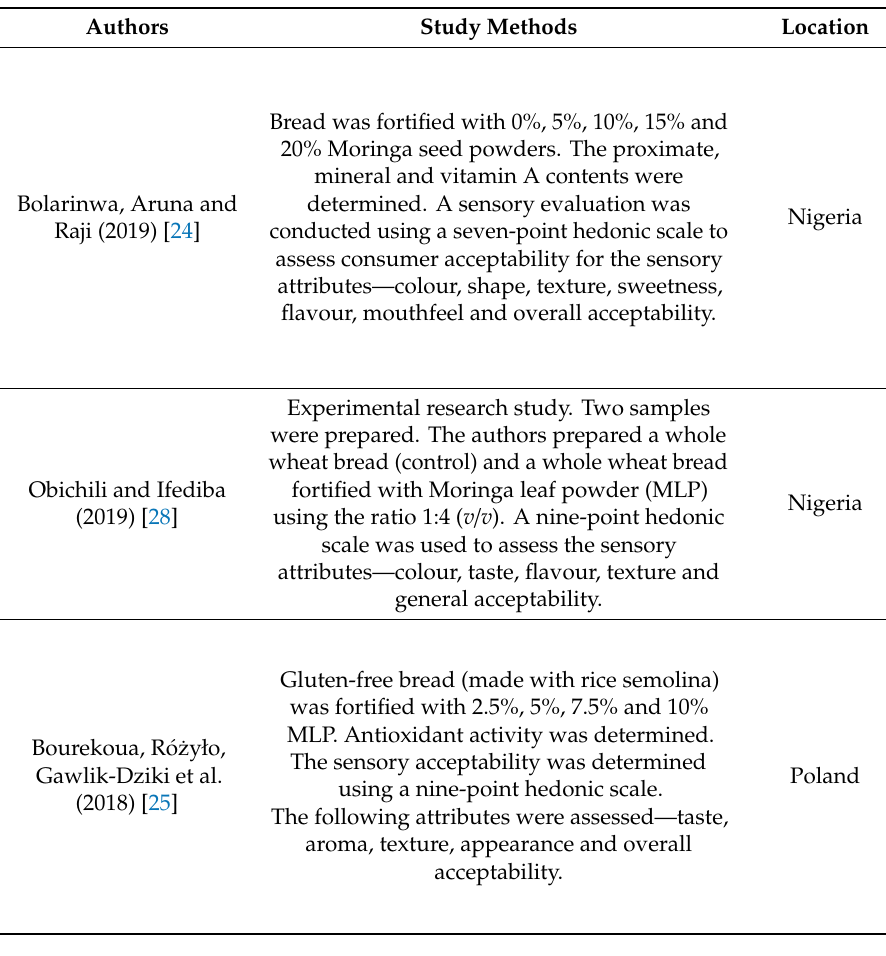
Table 1. Studies conducted on the addition of Moringa to